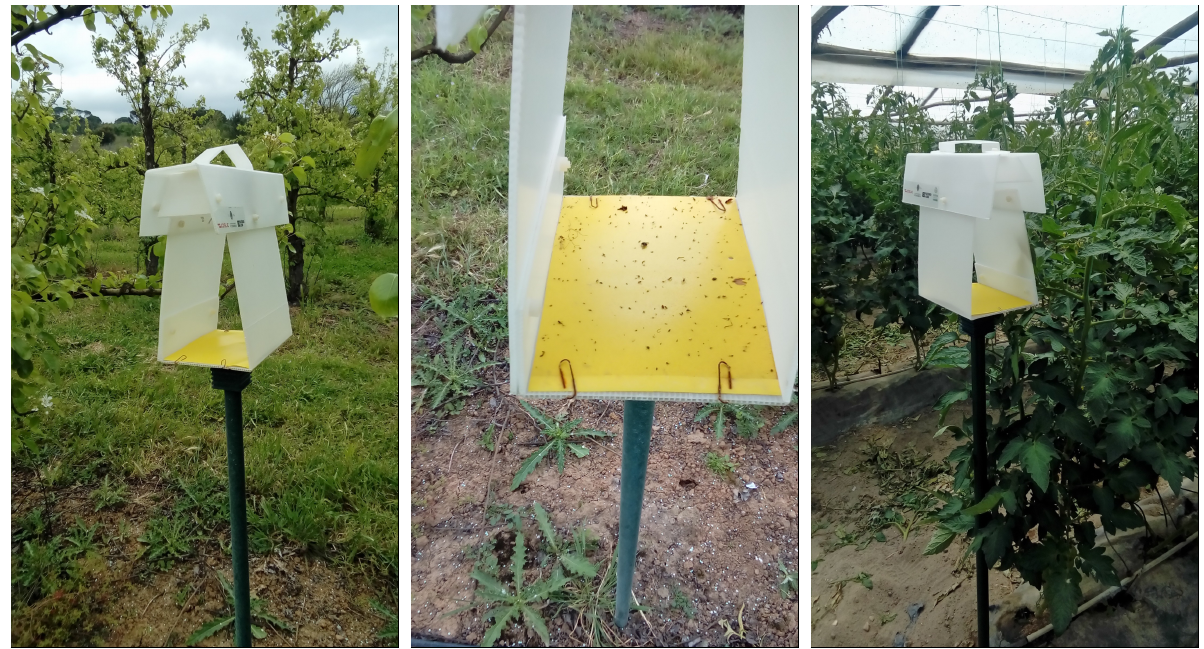
Figure A1. More examples of trap structures at the